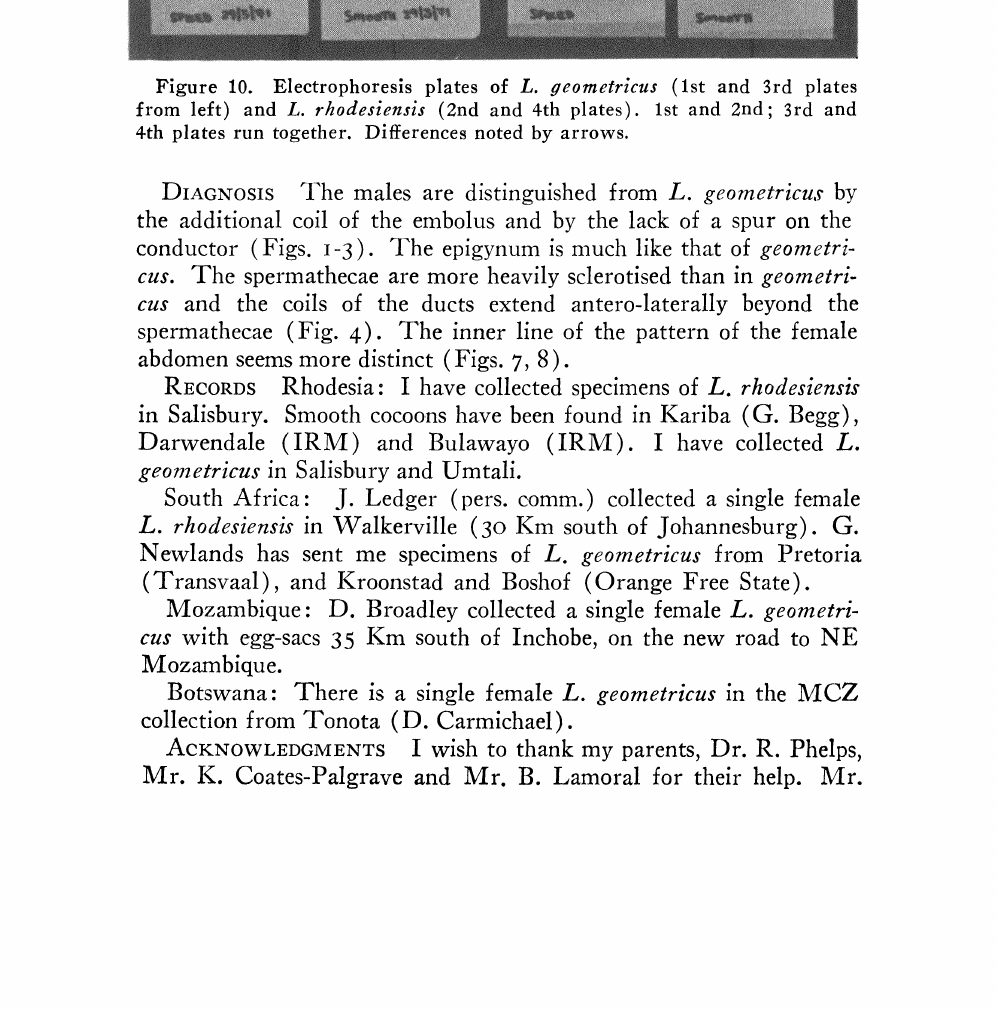
Figure 10. Electrophoresis plates of L. geometricus (lst and 3rd plates from left) and L. rhodesiensis (2nd and 4th plates). 1st and 2nd; 3rd and 4th plates run together. Differences noted by